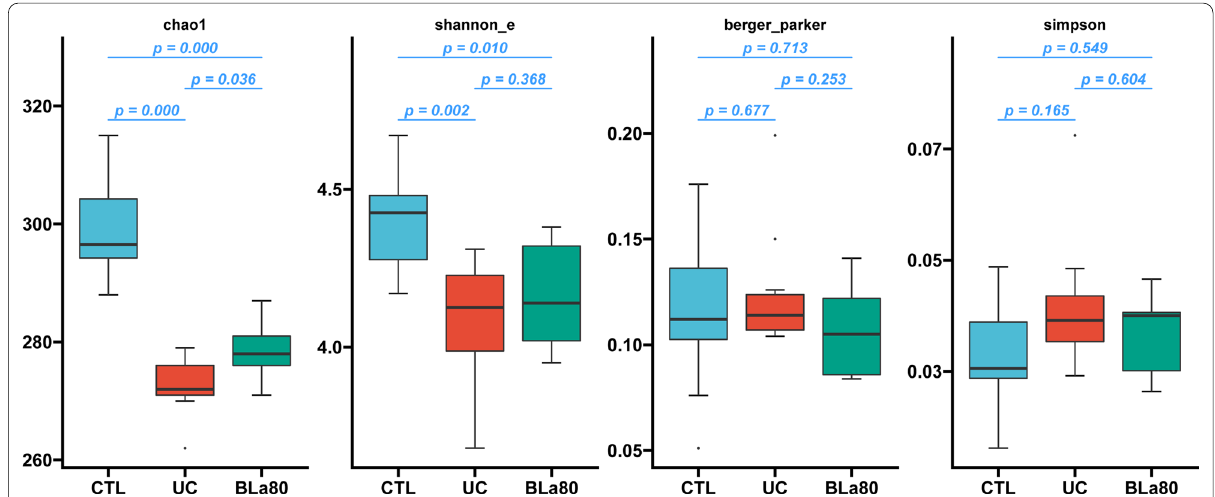
Fig. 3 Effect of BLa80 on the α diversity of gut microbiota. No differences were detected in the diversity (shannon_e, berger_perker, and simpson metrics) but richness (Chao1 index) in the GI microbiota increased in the Bla80 group